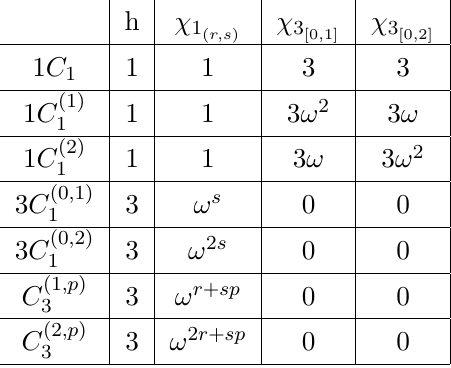
Table 5 . Characters of